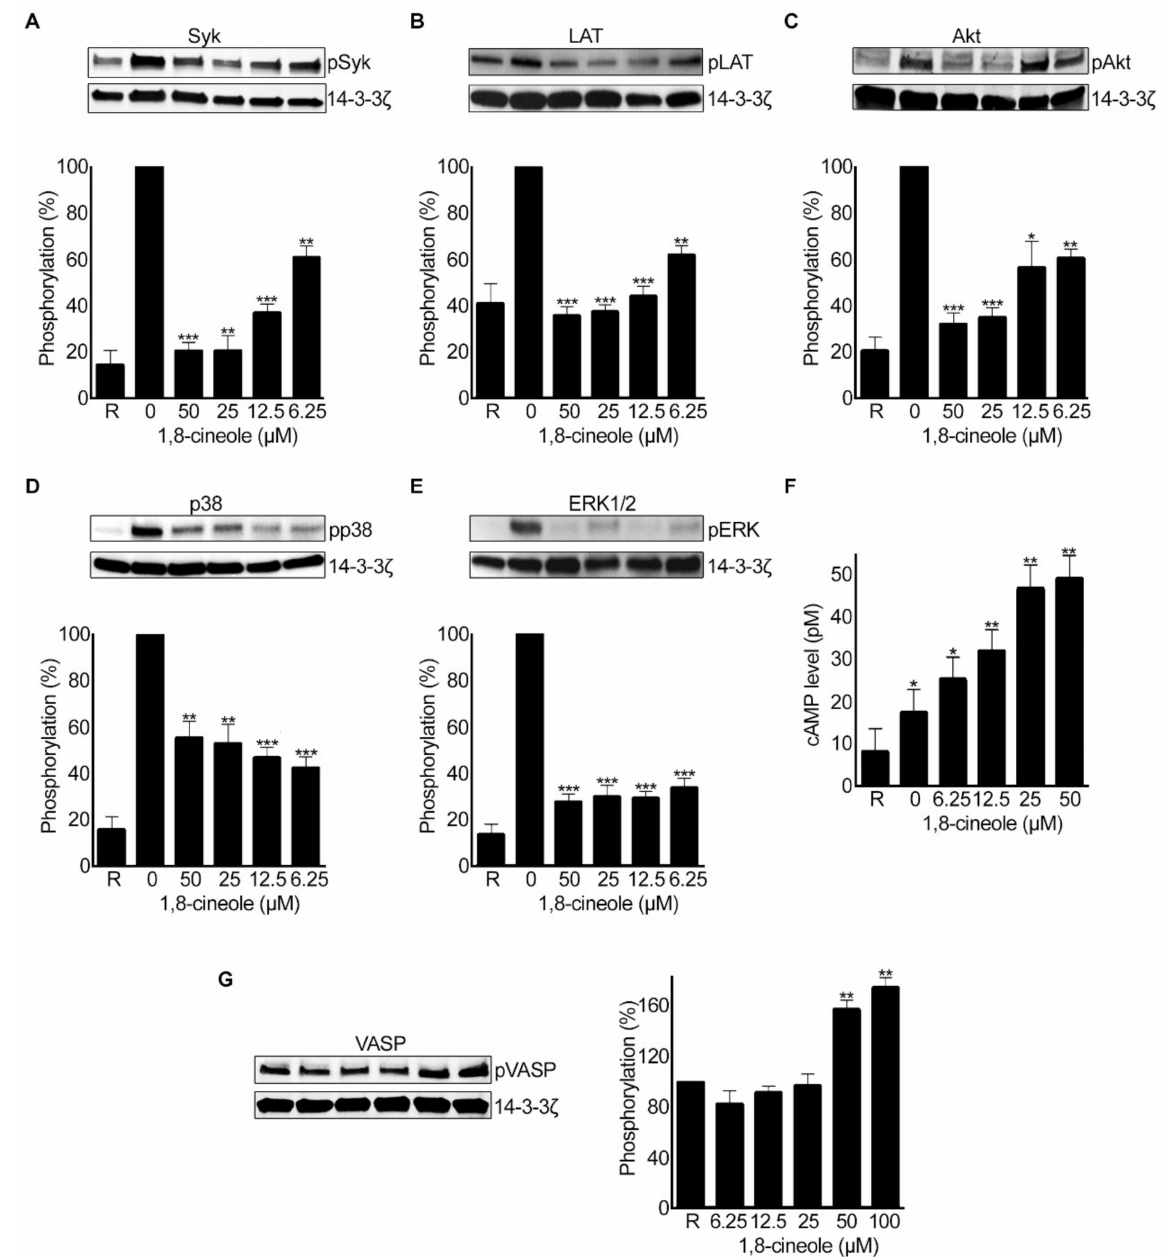
Figure 9. Effect of 1,8-cineole on specific signalling proteins and cAMP levels in platelets. Human isolated platelets (4 × 10 8 cells/mL) were treated with a vehicle control (0) or various concentrations of 1,8-cineole for 5 min before stimulation with CRP-XL (0.5 µ g/mL) for 5 min in an aggregometer at 37 ◦ C. Then, the cells were lysed using reducing sample treatment buffer and analysed in SDS-PAGE followed by immunoblots using various phospho-specific antibodies. The impact of 1,8-cineole on the phosphorylation of pSyk (Y525/526) ( A ), pLAT (Y200) ( B ), pAKT (S473) ( C ), pp38 ( D ), and pERK1/2 ( E ) was analysed using selective phospho-specific antibodies for these proteins in immunoblots. ( F ) the level of cAMP in platelets that were treated with a vehicle control or various concentrations of 1,8-cineole was measured using a cAMP ELISA kit in line with the manufacturer’s instructions. Data represent mean ± SEM. ( n = 4). ( G ), the phosphorylation of VASP (S157) was analysed using platelets that were treated with a vehicle control or different concentrations of 1,8-cineole. The level of 14-3-3 ζ was detected as a loading control in all these blots. The blots shown are representative of three separate experiments. Data represent mean ± SEM ( n = 3), normalised to loading control. The p values shown (* p < 0.05, ** p < 0.01 and *** p < 0.001) are as calculated by one way-ANOVA followed by Bonferroni’s correction for multiple